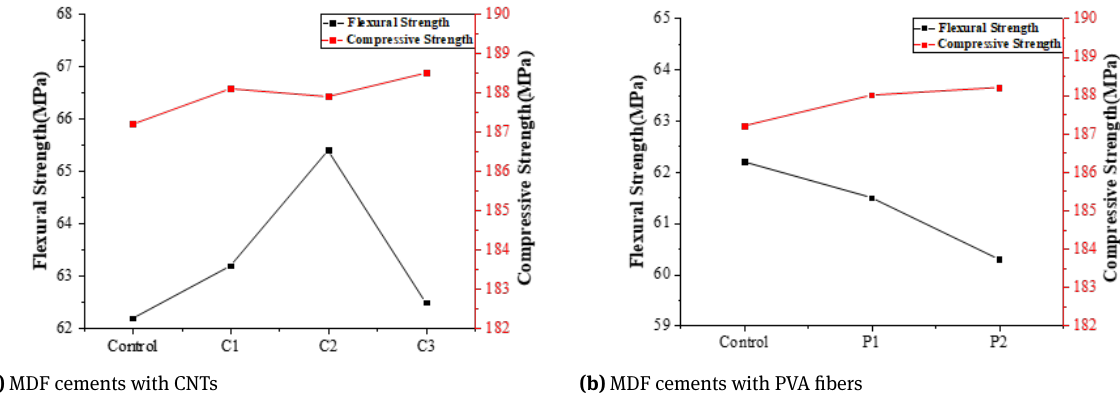
Figure 8: Flexural strength and compressive strength of specimens at 28 days.